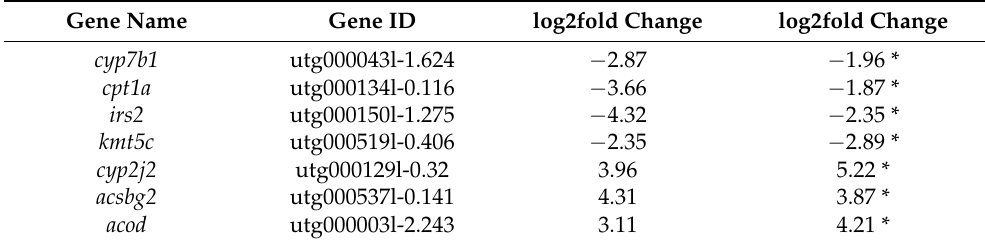
Table 5. Analysis of differentially expressed genes.